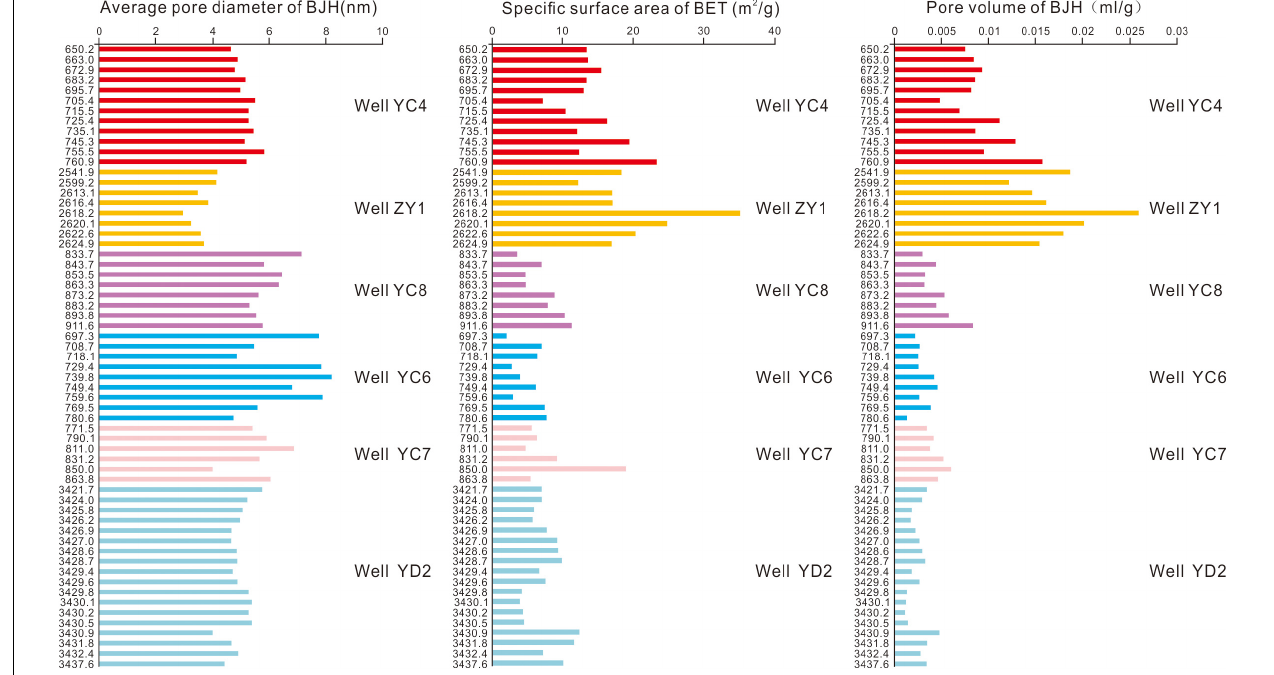
FIGURE 9 | Vertical distribution map of pore parameters in the Wufeng–Longmaxi Formation